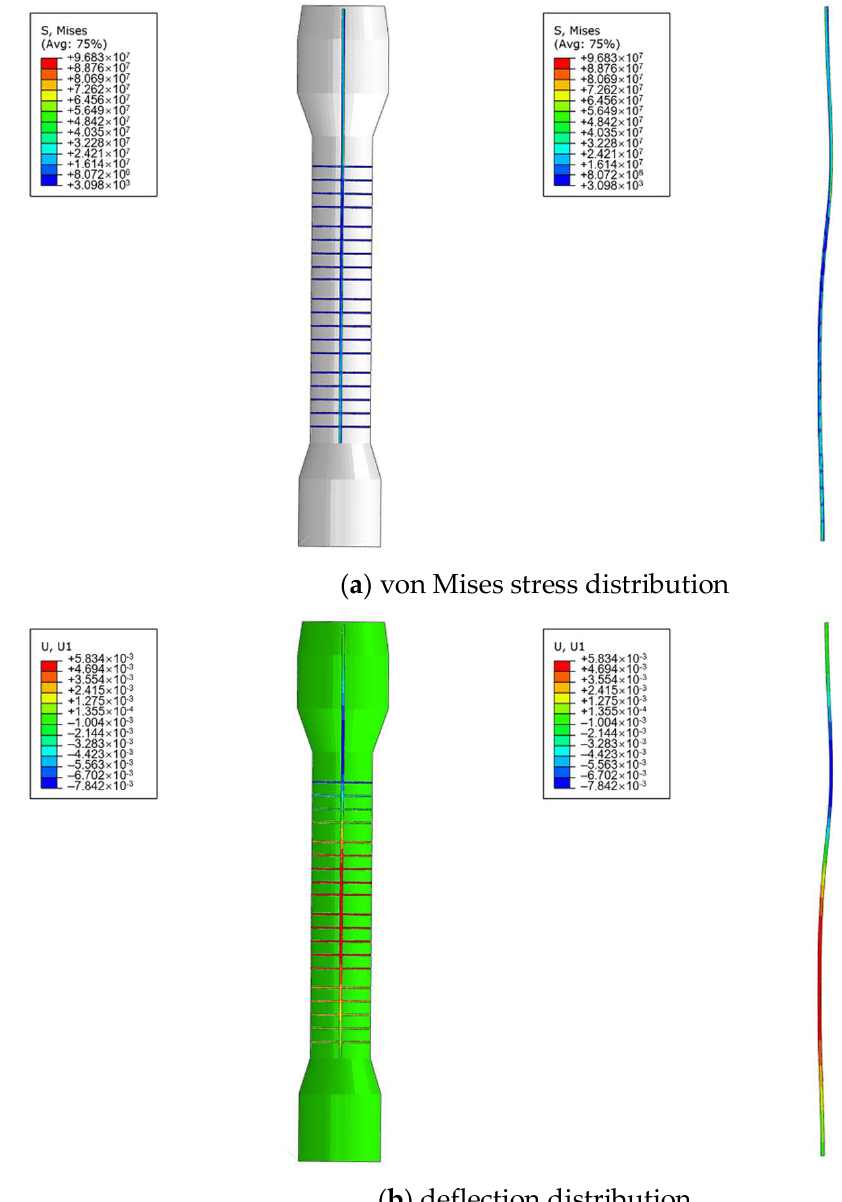
Figure 10. Finite element analysis results of the main